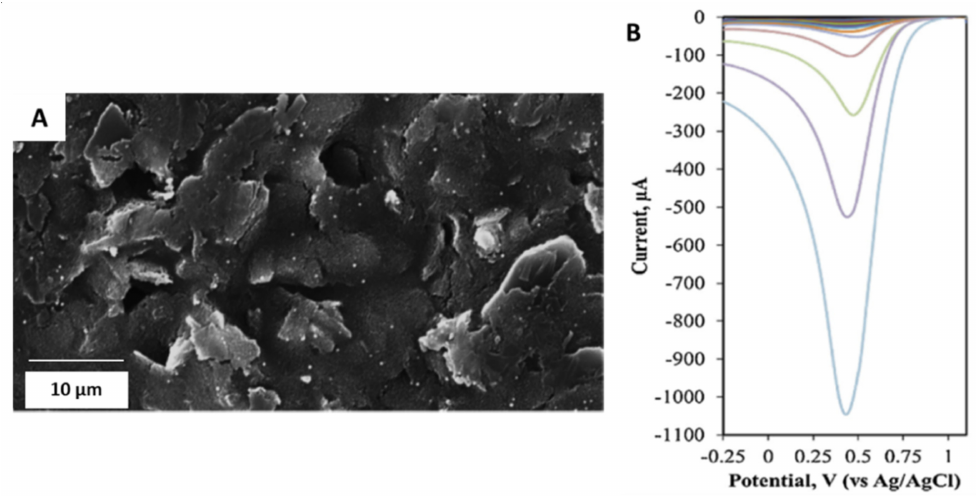
Figure 3. ( A ) SEM micrograph of Rh-NPs deposited on SPEs. ( B ) Cathodic stripping voltammograms of modified electrodes recorded using 150 µ L drop of supporting electrolyte with bromide. The cathodic linear sweep voltammetry scan was from 1.11 to − 0.25 V at a scan rate of 0.10 Vs − 1 . Reproduced with permission of Cunha-Silva and Arcos-Mart í nez, Sensors and Actuators B: Chemical; published by Elsevier, 2019